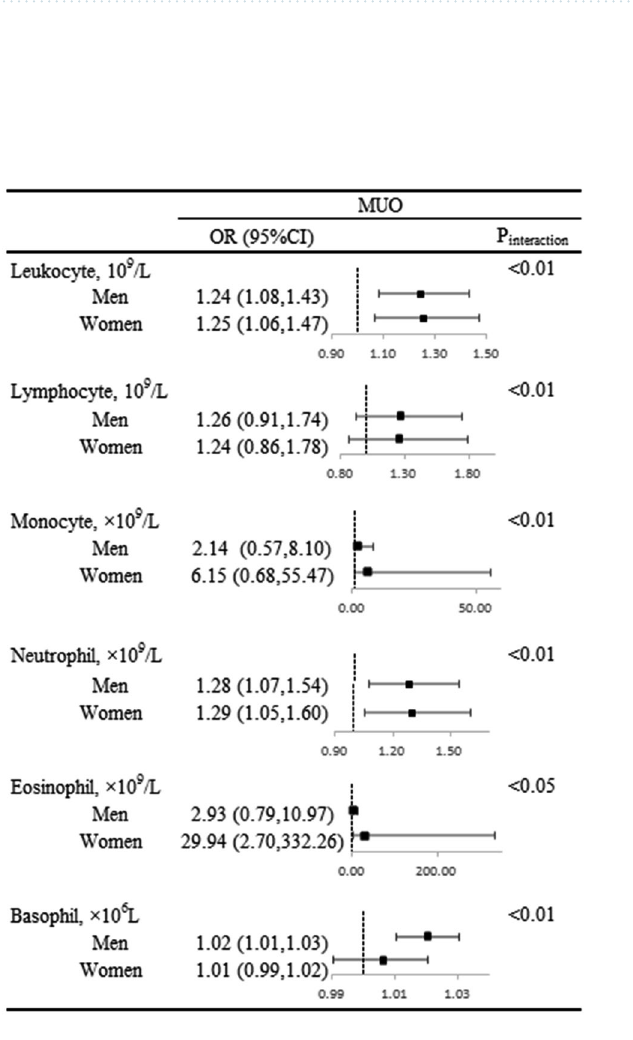
Figure 1. Subgroup analyses of the association between leukocyte-related parameters and MUO. Interactions between leukocyte-related parameters and sex on the MUO were tested by the likelihood ratio test with adjustment for the same variables as multiple models in Table 3 in addition to sex. Odds ratio and 95% CIs were showed by forest